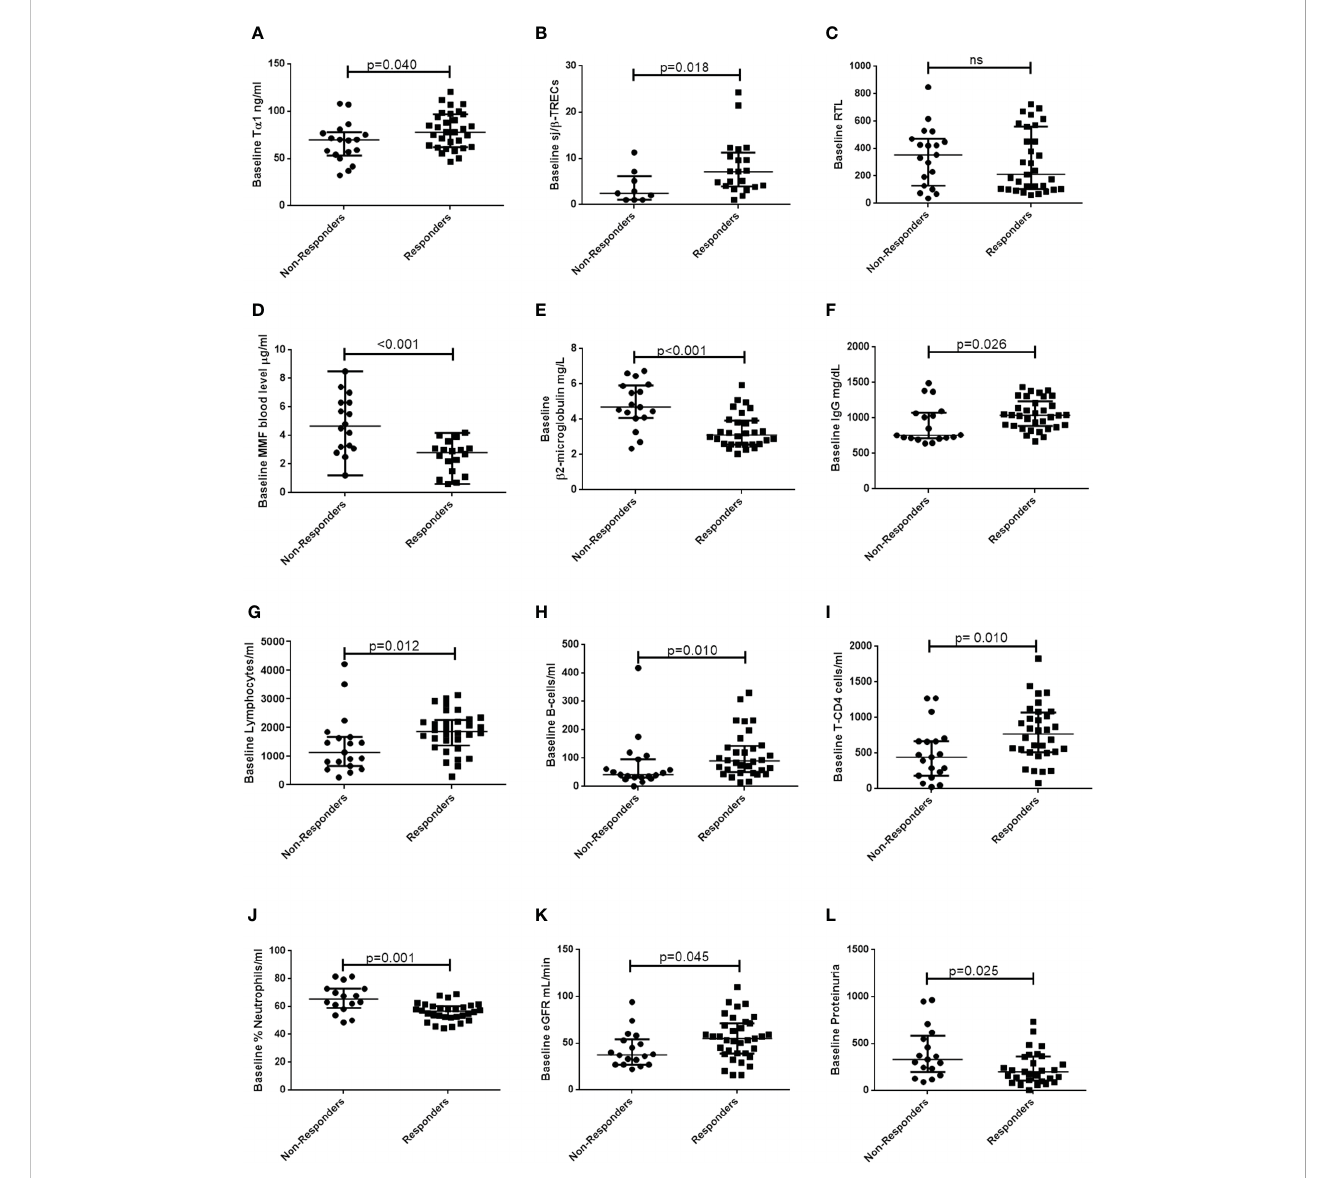
FIGURE 2 Baseline thymic function-related parameters, therapy-related factors, in fl ammatory-related markers, immune subsets and renal function-related factors in responders and non-responders KTR to the third dose of vaccine. Plots show comparisons of baseline levels of (A) Thymosin- a 1 (T a 1), (B) sj/ b TRECs ratio, (C) Relative Telomere length (RTL), (D) mycophenolate-mofetil (MMF) blood level, (E) b 2-microglobulin, (F) IgG, (G) lymphocytes, (H) B-cells, (I) T- CD4, (J) Neutrophils, (K) eGFR and (L) proteinuria between responders and non-responders KTR to the third dose of vaccine. Groups were compared using Mann Whitney- U test, considering statistically signi fi cant a p -value <0.05. eGFR, estimated glomerular fi ltration rate, calculated by CKD-EPI